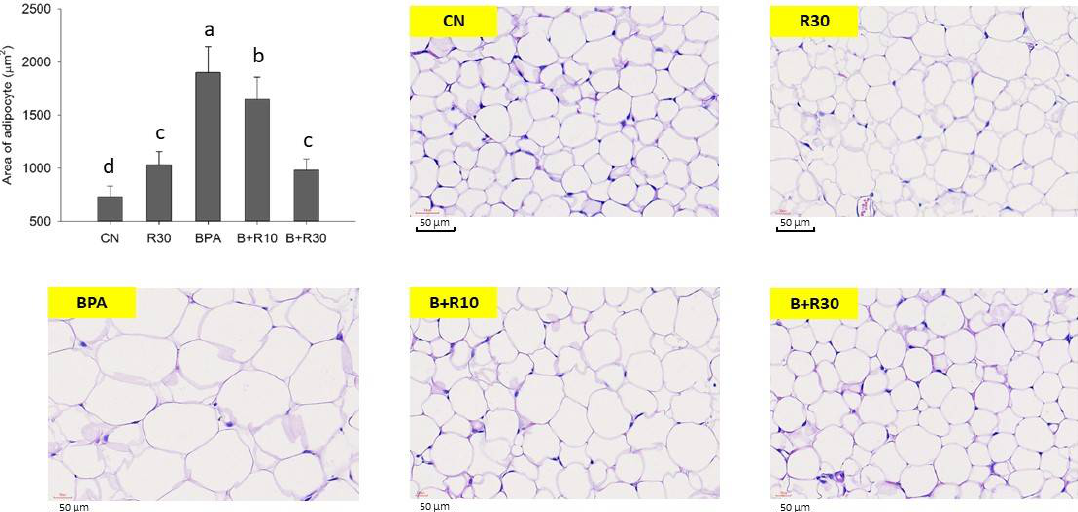
Figure 1. Representative pictures of lipid sections stained with haematoxylin and eosin (H&E) and examined under a microscope. a–d Values with different letters are specific to each group and show significant differences ( p < 0.05). CN = control group; R30 = group administered with 30 mg/kg/day of RBE; BPA = group administered with 50 μg/kg/day of bisphenol A; BPA+R10 = group administered with 10 mg/kg/day of RBE and bisphenol A; BPA+R30 = group administered with 30 mg/kg/day of RBE and bisphenol A . Data are expressed as mean ± SD ( n = 4–8).